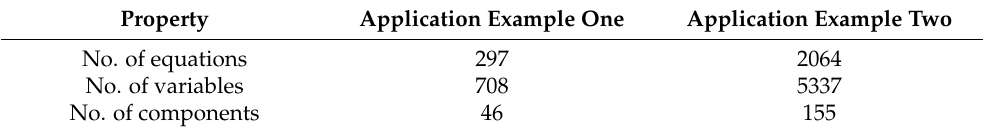
Table 1. Summary of the two application examples coolant distribution system Modelica